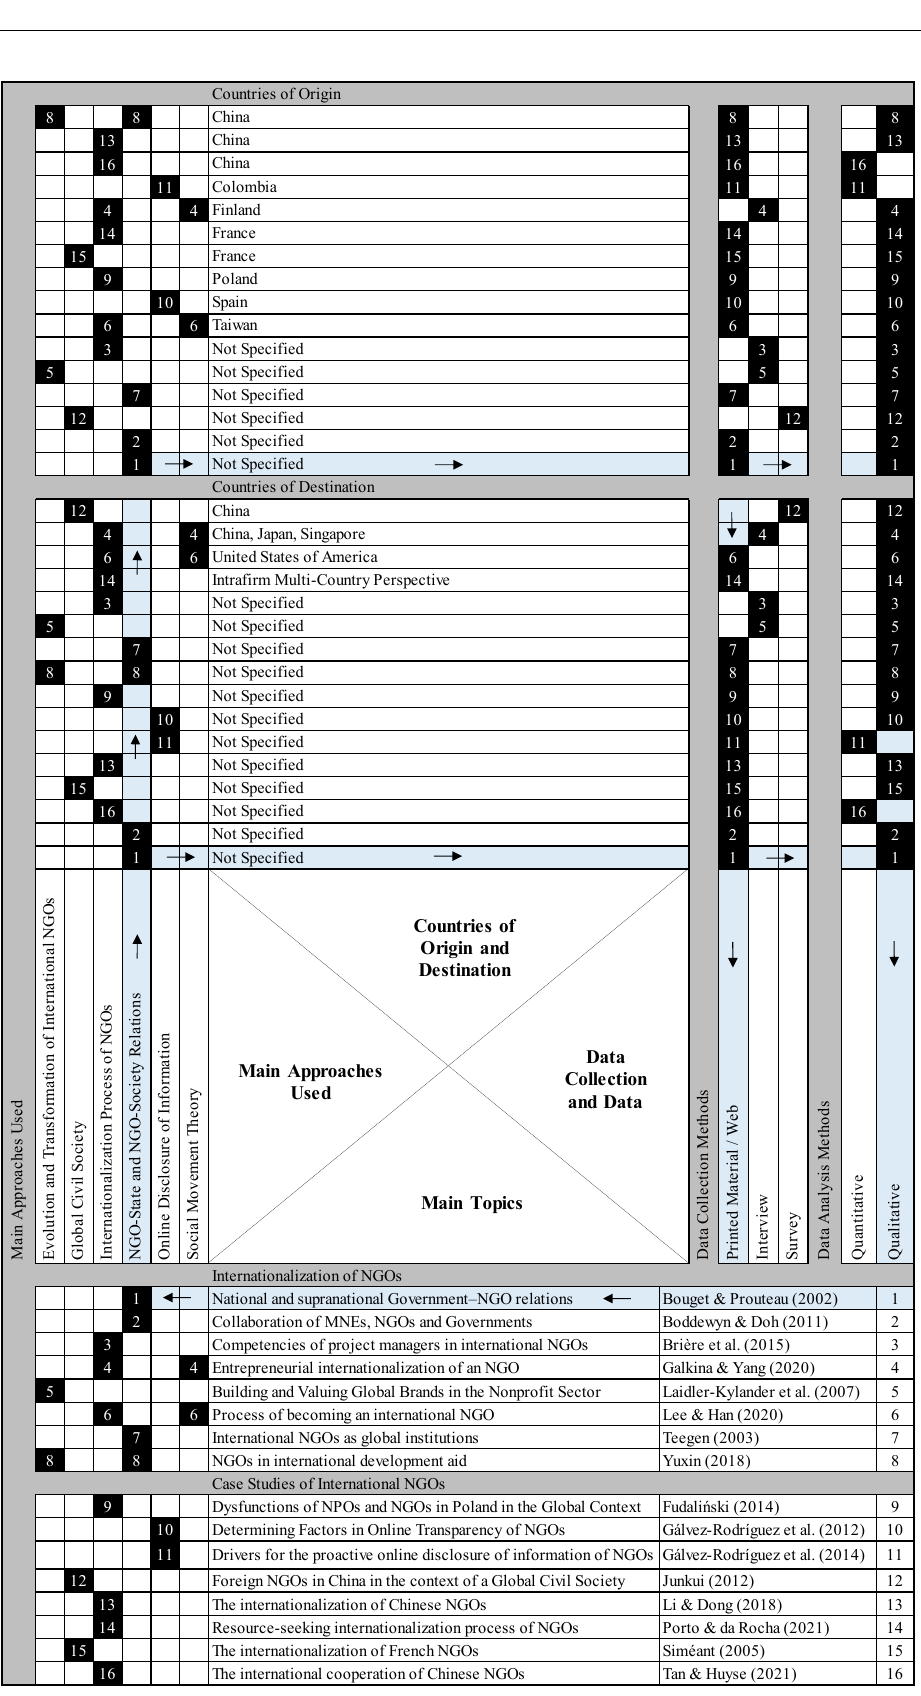
Figure 1. Characterization of the sample with X matrix (Bouget and Prouteau 2002; Boddewyn and Doh 2011; Brière et al. 2015; Galkina and Yang 2020; Laidler-Kylander et al. 2007; Lee and Han 2020; Teegen 2003; Yuxin 2018; Fudali ń ski 2014; Gálvez-Rodríguez et al. 2012, 2014; Junkui 2012; Li and Dong 2018; Porto and da Rocha 2021; Siméant 2005; Tan and Huyse 2021)